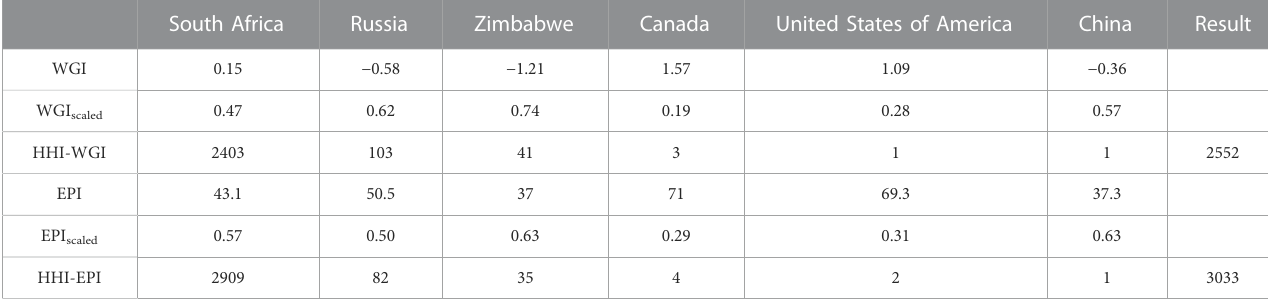
TABLE 3 Political and environmental risks of major platinum mine producing countries in the world. South Africa Russia Zimbabwe